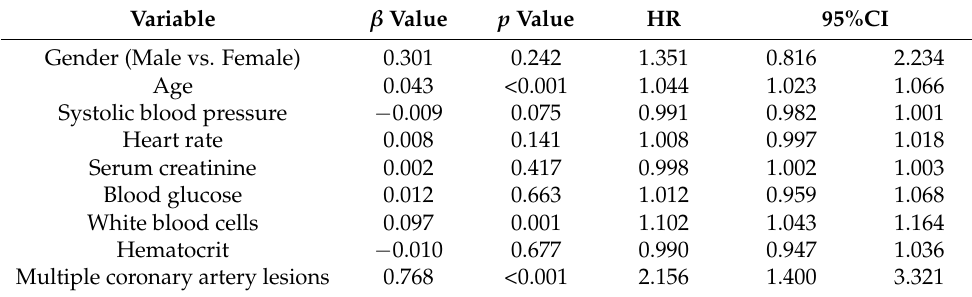
Table 2. Multivariate Cox regression analysis of MACCE in patients with ACS. Variable